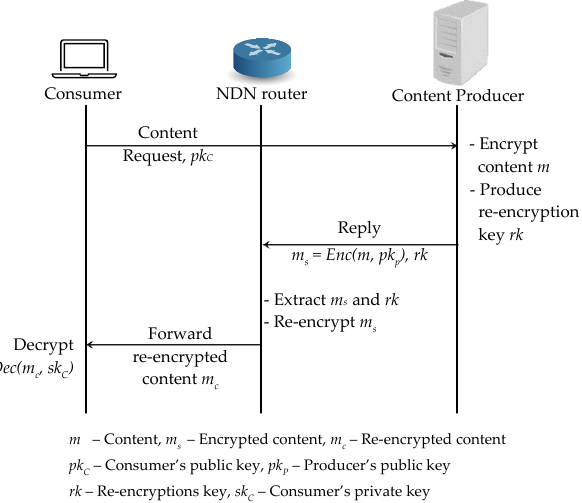
Figure 3. Basic Proxy Re-Encryption scheme application to NDN